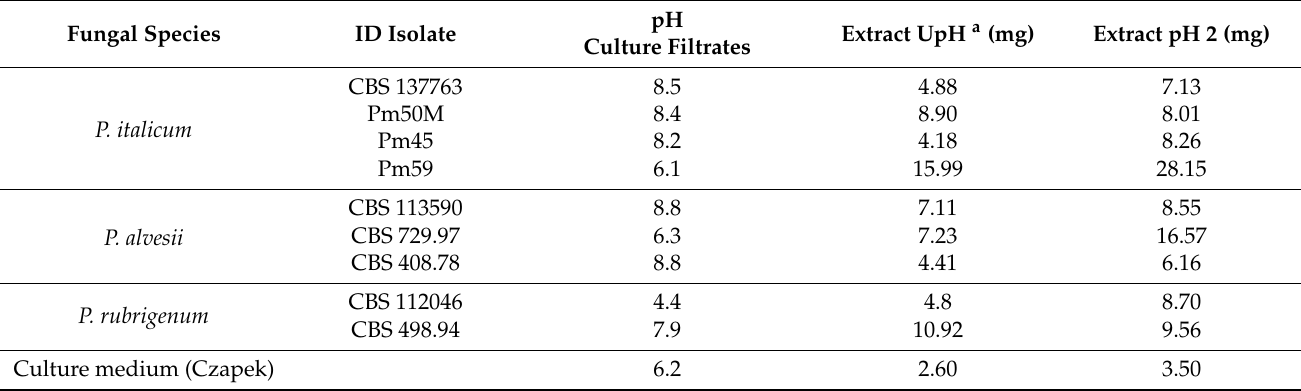
Table 2. Selected Phaeoacremonium species and isolates. Amount of fungal filtrates organic extract (mg) at different